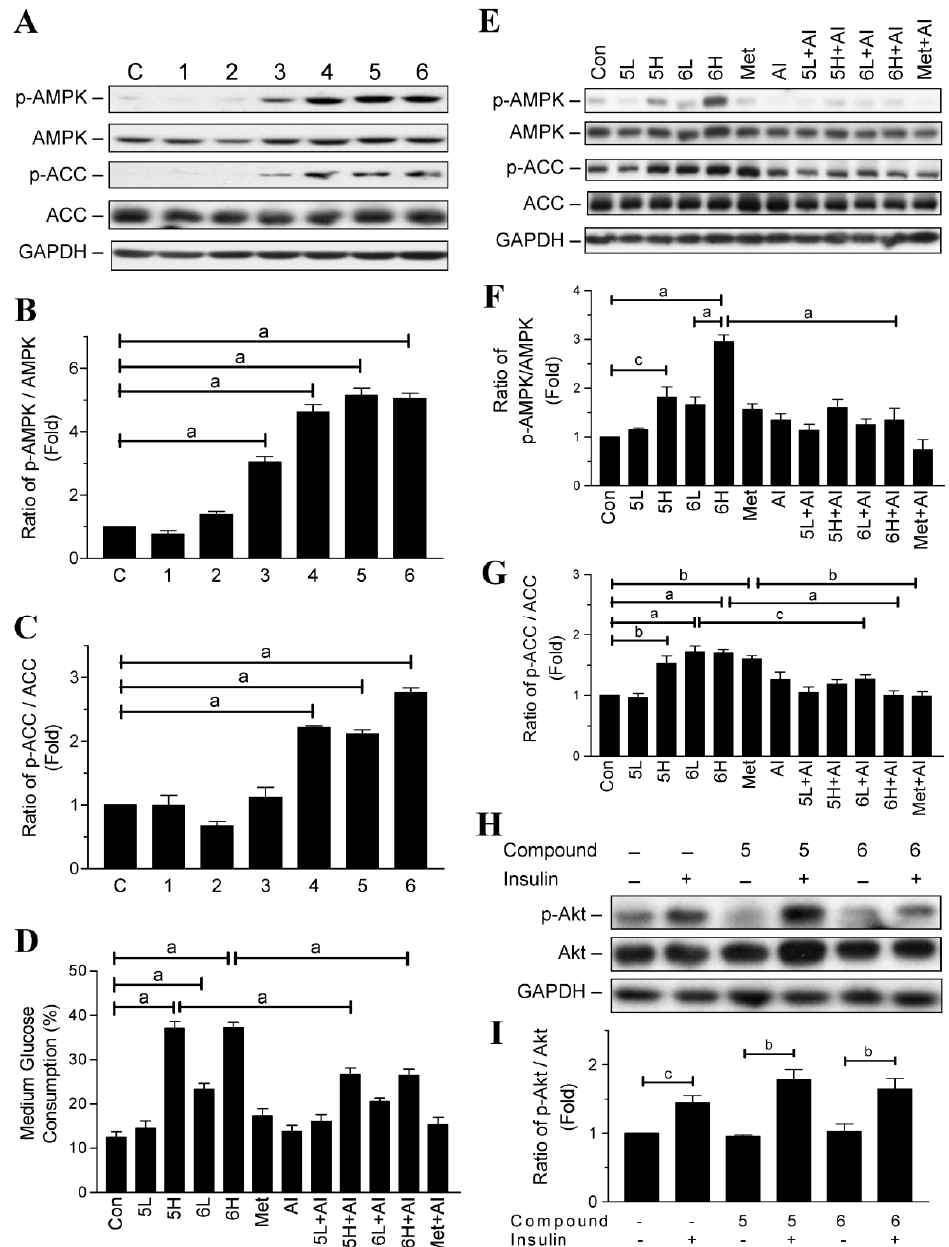
Figure 3. Effects of chalcone derivatives on 5 ′ -adenosine-monophosphate-activated protein kinase (AMPK) and Protein kinase B (Akt) signaling in 3T3-L1 adipocytes. ( A ) 3T3-L1 adipocytes were treated with or without the tested compounds (30 µg/mL) for 24 h, and then phosphorylated and total AMPK and acetyl-CoA carboxylase (ACC) proteins were detected by Western blotting; ( B , C ) quantitative results for the blots in panel A; ( D ) 3T3-L1 adipocytes were pre-treated with or without Dorsomorphin (10 µM; AI) for 30 min and then administered with low dosage (15 µg/mL; L) or high dosage (30 µg/mL; H) of compound 5 or 6 , or 30 µg/mL of metformin. The medium glucose consumption was detected after 12 h of incubation and the cells were harvested for protein analysis; ( E ) Western blotting for phosphorylated and total AMPK and ACC proteins; ( F , G ) quantitative results for the blots in panel E; ( H ) 3T3-L1 adipocytes were treated with 30 µg/mL of compounds 5 or 6 combined with or without insulin (0.32 µM) for 30 min to observe the phosphorylated and total Akt proteins; ( I ) quantitative results for the blots in panel H. Data are mean ± SD from three independent experiments. a : p < 0.001; b : p < 0.01; c : p < 0.05.